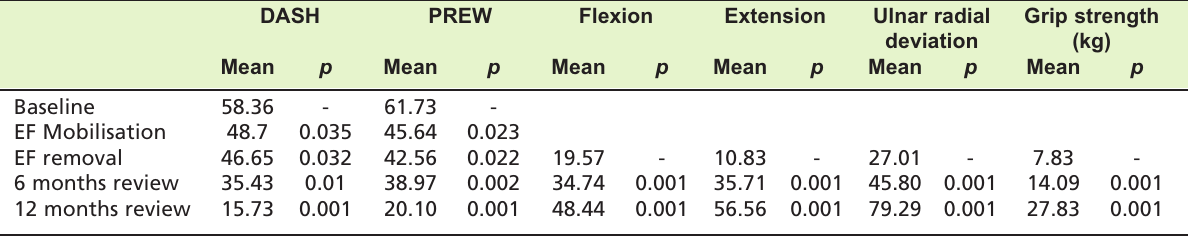
Clinical outcome: differences between each follow-up versus baseline at left side and between each follow-up Table II: versus EF Removal at ride side (Paired t-test)